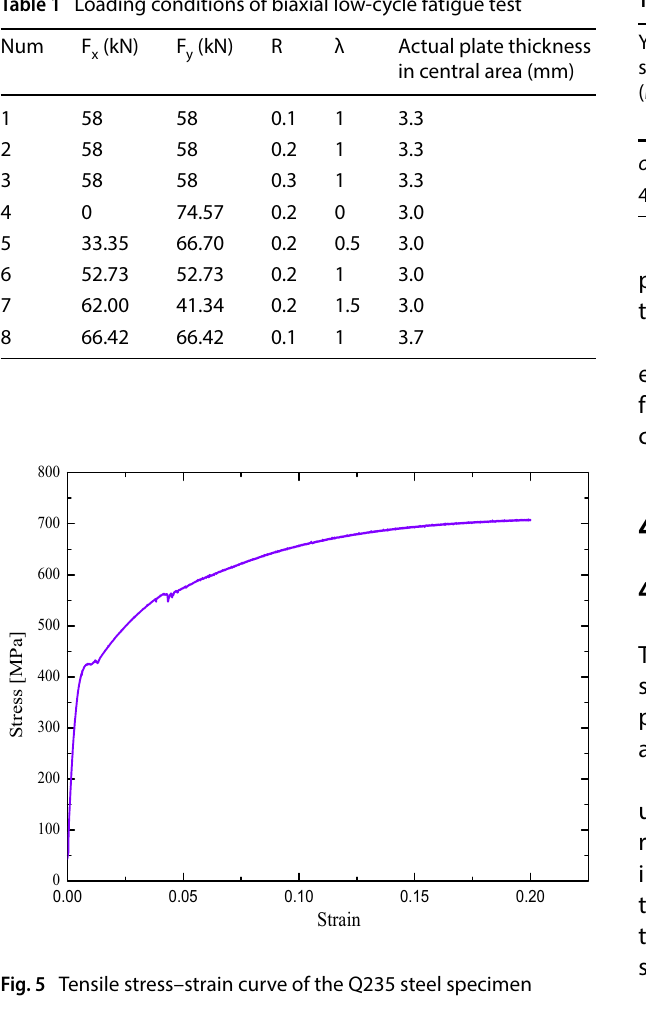
Table 2 Material properties of Q235